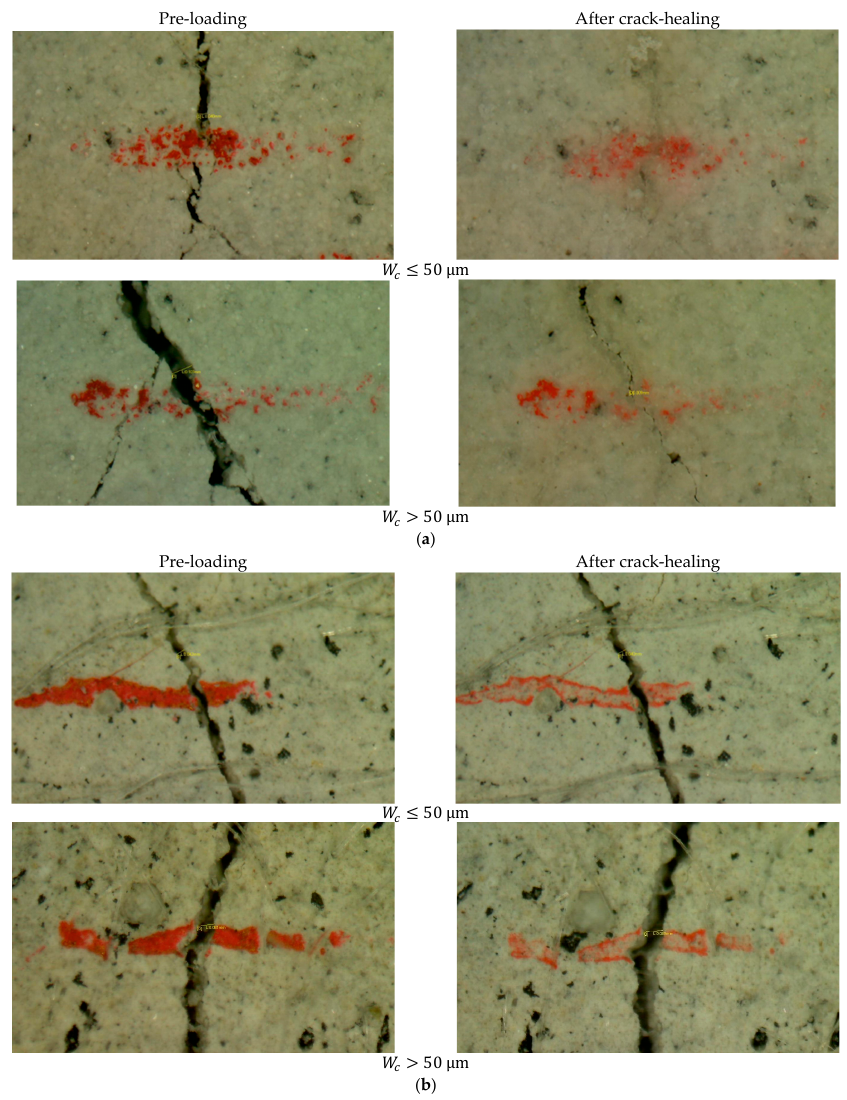
Figure 6. Representative crack healing phenomena of: ( a ) M-W and ( b ) M-O mixtures.